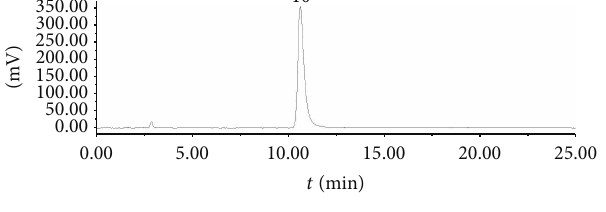
Figure 2: HPLC chromatograms of Tween-80.